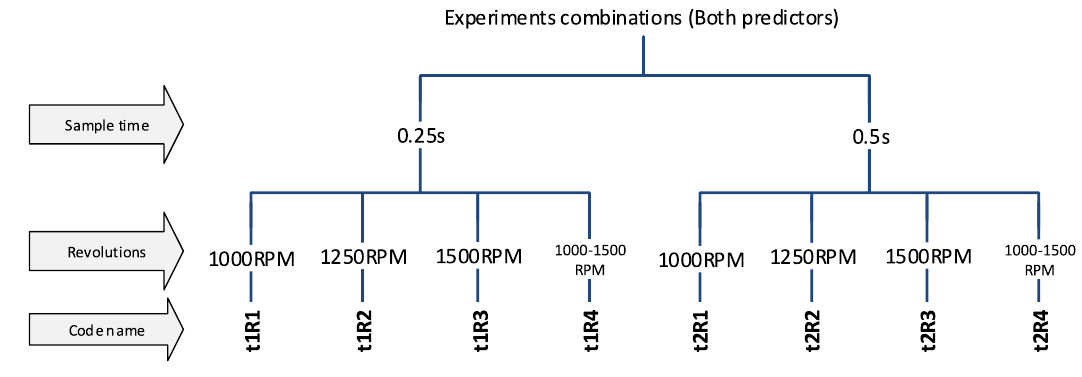
Figure 8. The code names of experiments (the combined